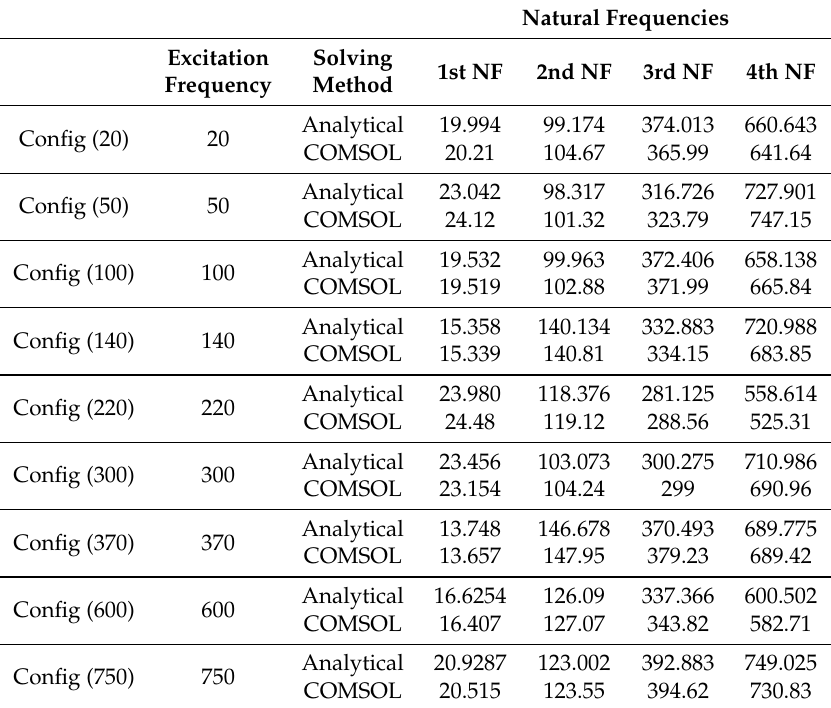
Table 3. Natural Frequencies for different optimized